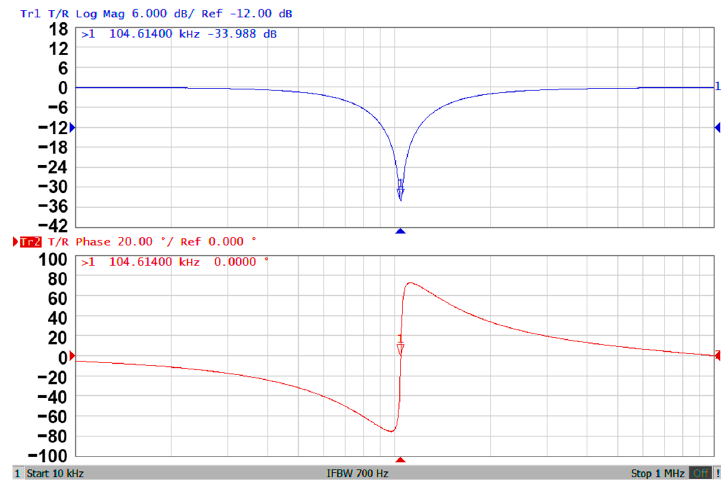
Figure 10. The experimental results of gain and phase responses of the LPF in Figure 2.